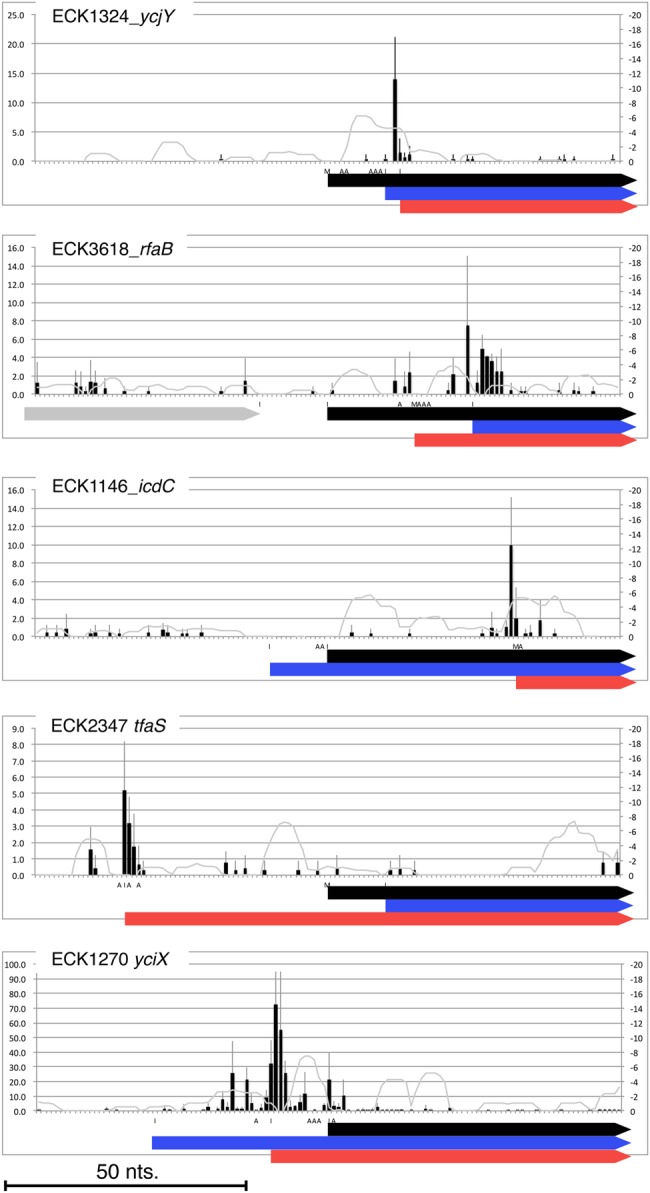
TetRP signals near initiation region of triply annotated genes. An average + SD value of TetRP signal at each genome position is shown by a black bar and a line. (The TetRP signal is shown at 15-nt 5’ from the 3’-end of the read, corresponding to the first base of P-site codon.) The calculated hybridization stability with anti-ribosome binding site of 16S rRNA (ΔG) is shown by gray line. Coding region starting from the 2006 (top, black), 2014 (middle, blue), and TetRP (bottom, red) annotations are indicated as thick arrows and an upstream gene is sown by a thick gray arrow. A, I, or M in X-axis indicates, A: a position 15-nt. 3’, where sequence reads giving the signal at the position, is adenine, I: end or start position of a gene, or M: both of them. This figure is available in black and white in print and in colour at DNA Research online.